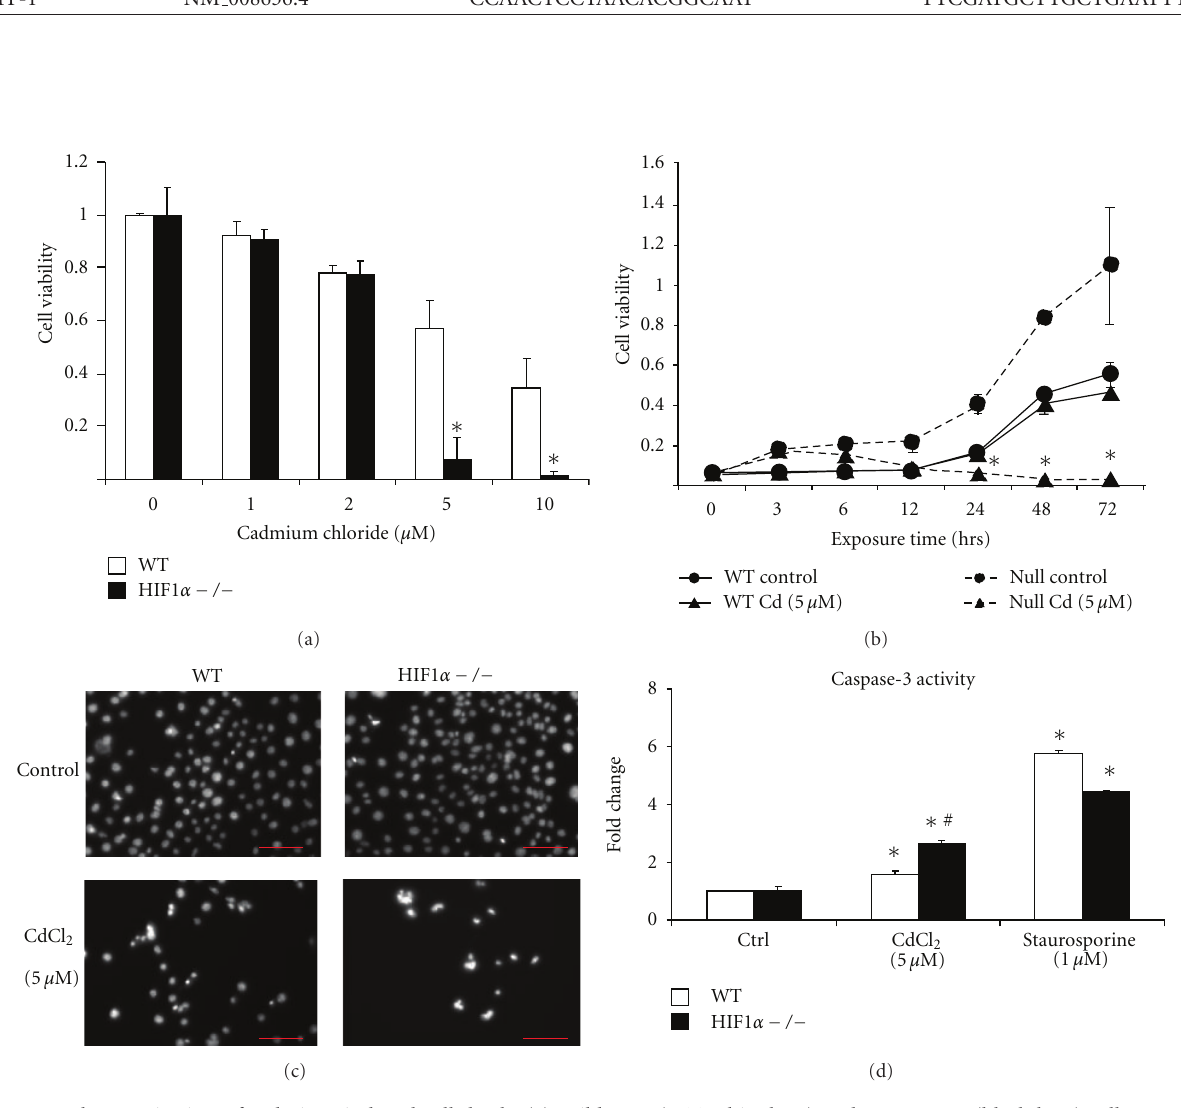
Figure 1: Characterization of cadmium-induced cell death. (a) Wild-type (WT, white bars) and HIF1 α − / − (black bars) cells were left untreated (0) or exposed to 1, 2, 5, 10 μ M CdCl 2 for 72 hours. Cell viability was assessed using a standard MTT assay. Untreated control values within cell type were set to 1. ∗ P < 0 . 05 compared to the corresponding controls, n = 4. (b) Wild-Type (WT, solid line) and HIF1 α − / − (Null, dashed line) were left unexposed (Control, circles) or Cadmium (Cd, 5 μ M, triangles) for various times and cell viability was measured using MTT assay. ∗ P < 0 . 05 compared to the corresponding controls. (c) Wild-type (WT) and HIF1 α − / − cells were left untreated (Control) or exposed to 5 μ M CdCl 2 for 24 hours and nuclear morphology was observed after staining with Hoechst 33342 dye using fluorescence microscopy. (d) Wild-type (WT, white bars) and HIF1 α − / − (black bars) cells were left untreated (Ctrl) or exposed to CdCl 2 (5 μ M, 24 hours), or staurosporine (1 μ M, 4 hours). Caspase-3 activity was measured using EnZChek caspase-3 assay kit number 2 (Molecular Probes). ∗ P < 0 . 05 compared to the corresponding controls, n = 4. # significant compared to wild type, P < 0 . 05, n =